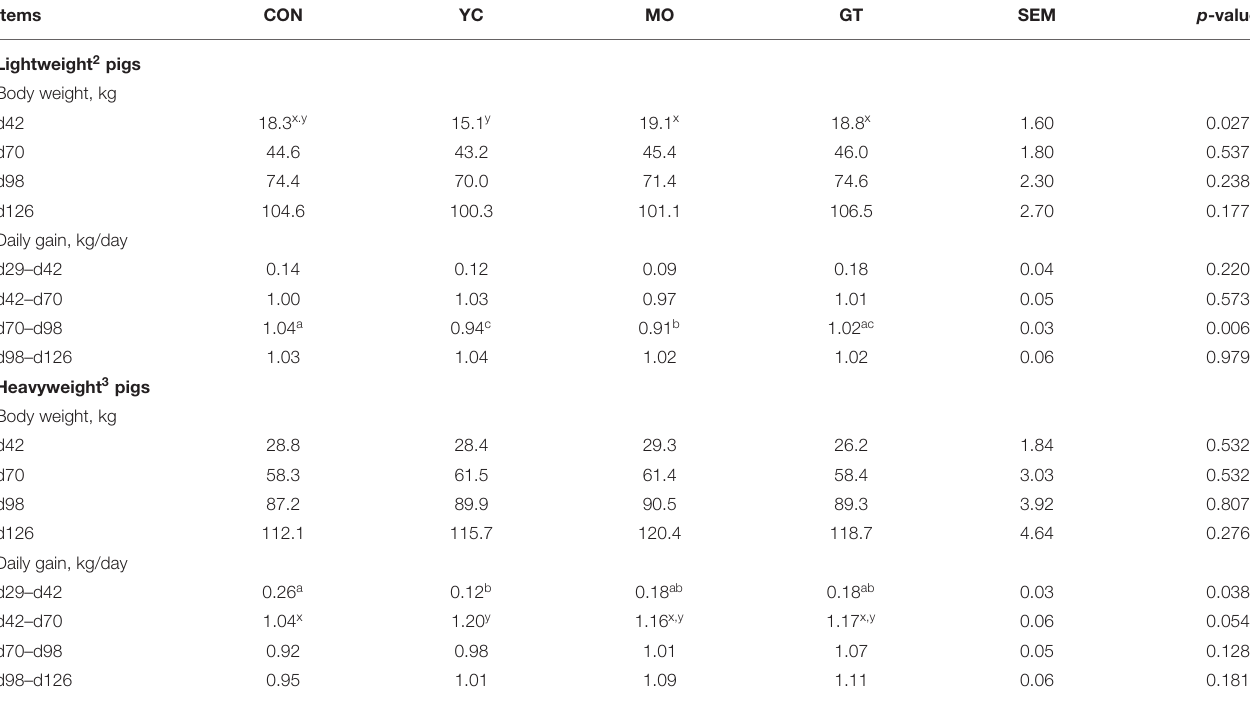
TABLE 9 | Grow-finish (d29–d126 after weaning) performance of offspring deemed light and heavy at weaning from sows provided feed additives during gestation and lactation and weaned to an off-site facility 1,4 . Items CON YC MO GT SEM p